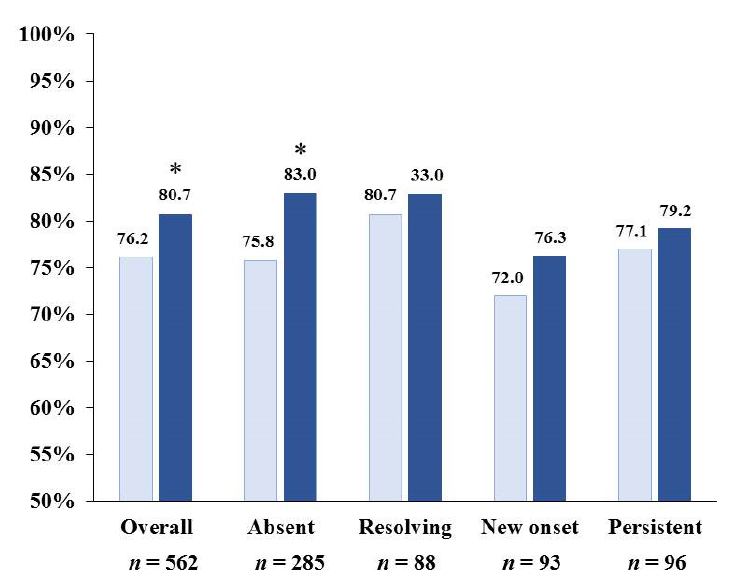
Figure 1. Use of Renin-Angiotensin-Aldosterone Inhibitors at baseline (light blue) and at 12-month visit (dark blue) in the whole cohort and in each HK subgroup (see text for definition of subgroups). * p < 0.05 vs. baseline.